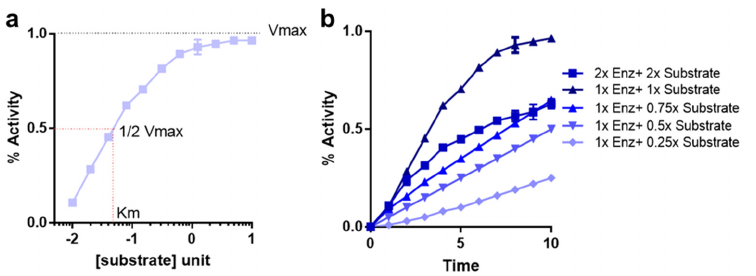
Figure 1. Reaction kinetics and velocity plots. ( a ) Michaelis-Menten reaction rate is plotted as a function of substrate concentration. Reaction rate is saturated at Vmax. ( b ) Reaction progress curve for initial velocity measurement under a varying concentration of substrates and enzyme as indicated.